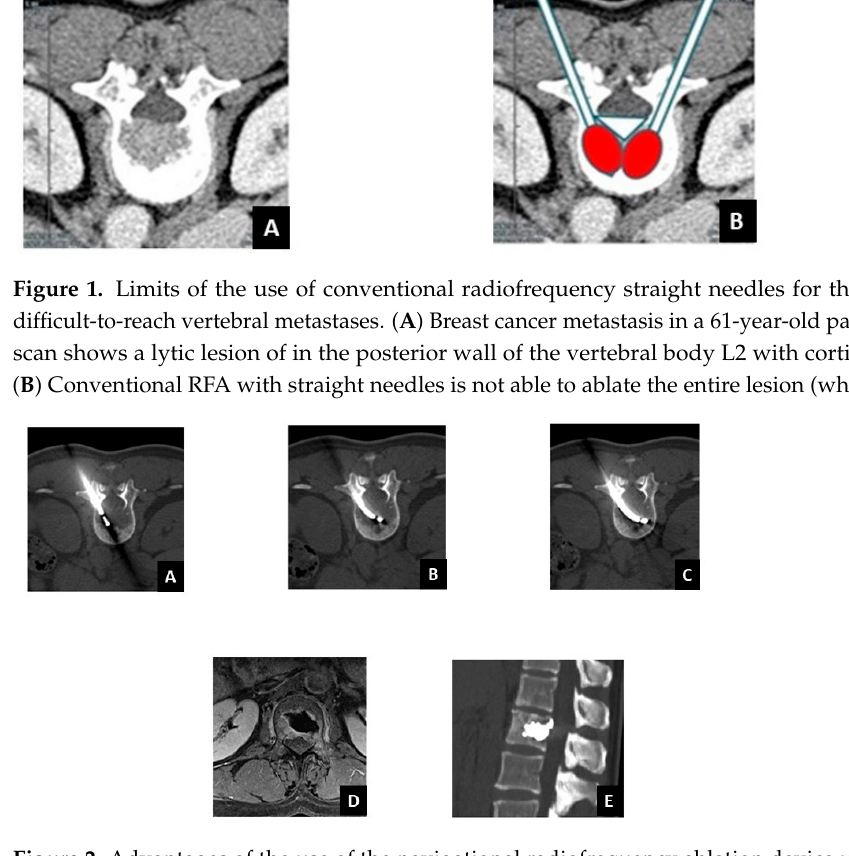
Figure 2. Advantages of the use of the navigational radiofrequency ablation device using steerable needles instead of conventional straight ones. L2 breast cancer metastasis (same patient from Figure 1). ( A – C ) Placement of targeted radiofrequency ablation device to obtain complete necrosis of the tumor lesion located in a difficult-to-access location. ( D , E ) Follow-up imaging after one month after the tRFA-VA treatment. ( D ) MRI showed a layer of granulation tissue around the ablated zone. This is the typical inflammatory reaction after tRFA ablation. ( E ) CT scan showed the right position of the polymethylmethacrylate used for VA. After tRFA, vertebroplasty was performed to strengthen the bone in order to avoid pathological fracture. Table 1. Summary of studies reporting on the use of a navigational radiofrequency ablation device for the treatment of spinal lesions. Author